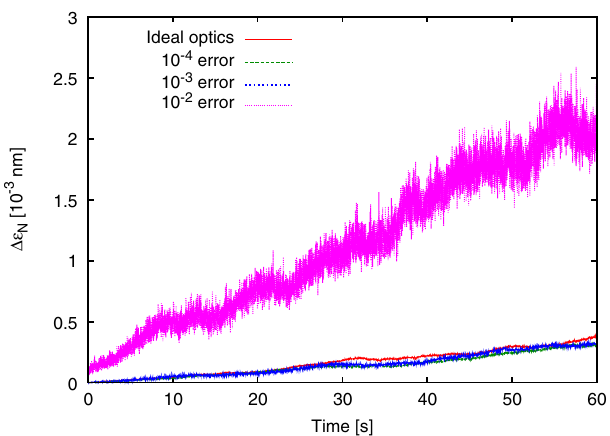
FIG. 15. (Color) Emittance growth vs time for a basic feedback system using 30 BPM patterns (1324 BPMs) and 80 correctors and with an expected emittance growth rate of (cid:6) 0 : 40 (cid:5) 10 (cid:1) 3 nm = min . Apart from the 1% error, the feedback perform- ance is not strongly affected by imperfect knowledge of the machine optics.